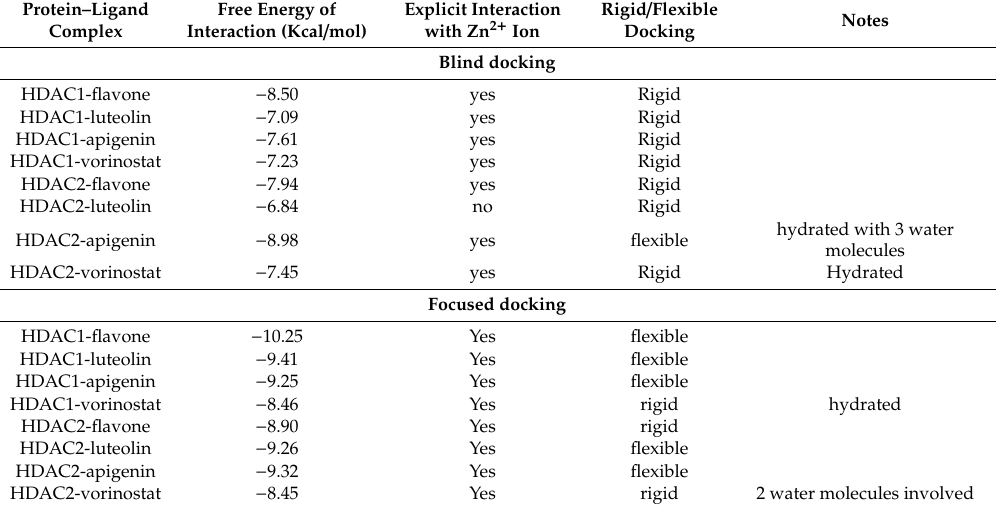
Table 1. Predicted energies of interaction from molecular docking simulations of HDAC1 / 2 with flavones as ligands and inhibitor vorinostat as a